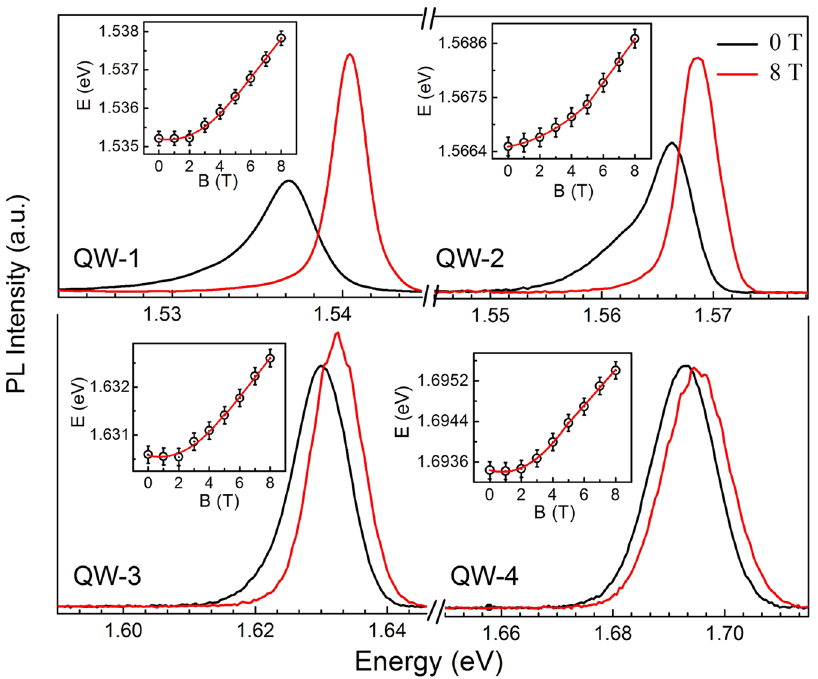
Figure 3. 4.2 K PL spectra of QW-1 (190 Å), QW-2 (100 Å), QW-3 (50 Å), QW-4 (30 Å) at 0 T (black curve) and 8 T (red curve) magnetic field. Blue shift of PL peak energy ( Δ E) as a function of B is shown in the respective